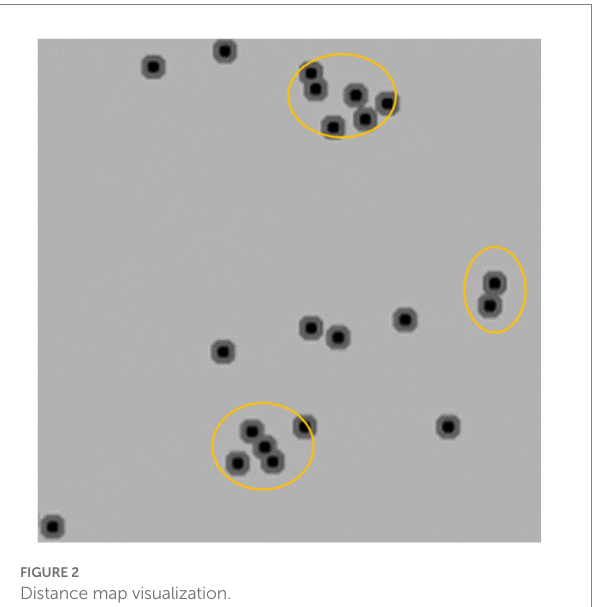
FIGURE 2 Distance map